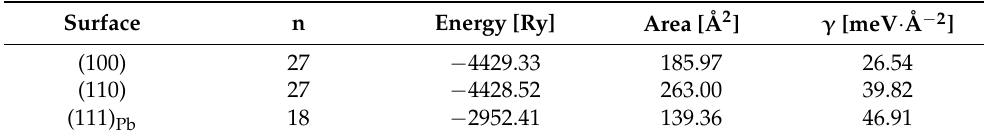
Table 3. Total electronic energy, number of PbTe formula contained and area and surface energy γ obtained for (100), (110) and (111) Pb clean surface models. Note that such computed values are in full agreement with [1].